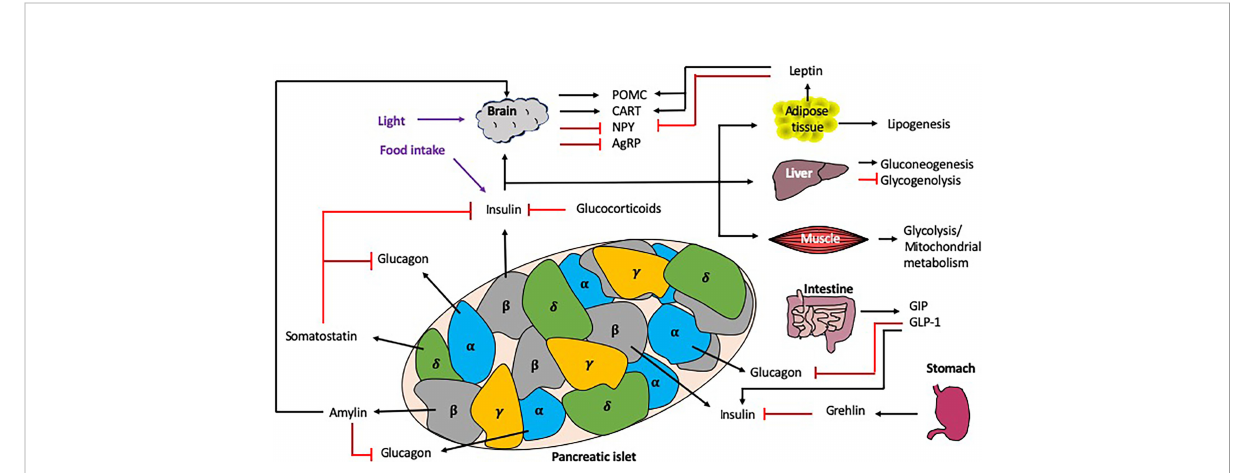
FIGURE 4 Interactions regulating blood glucose homeostasis. Blood glucose homeostasis is controlled by many signals both locally within the pancreas, and more distally, from the brain, liver, muscle, intestine, stomach and adipose tissue. Within the pancreatic islets, the a cells secrete glucagon, the b cells secrete insulin (and amylin), g cells secrete pancreatic polypeptide and the d cells secrete somatostatin. In response to high glucose e.g. from dietary intake, the islet bb cells secrete insulin, which is detected by multiple tissues in the periphery, leading to the synthesis or induction of many molecules/pathways e.g. lipogenesis and gluconeogenesis, as well as the inhibition of others e.g. glycogenolysis. Importantly, there are many mechanisms of regulation to control the secretion of insulin both locally (e.g. glucagon and somatostatin) and more distally, e.g. intestine/stomach via hormones (e.g. grehlin and glucocorticoids) and incretins (GIP/GLP-1). Exogenous circadian modulation factors such as light and food intake (shown in purple) can also regulate blood glucose homeostasis, as can endogenous factors such as glucocorticoids, which also show rhythmicity. Black arrows indicate induction, red lines indicate inhibition.